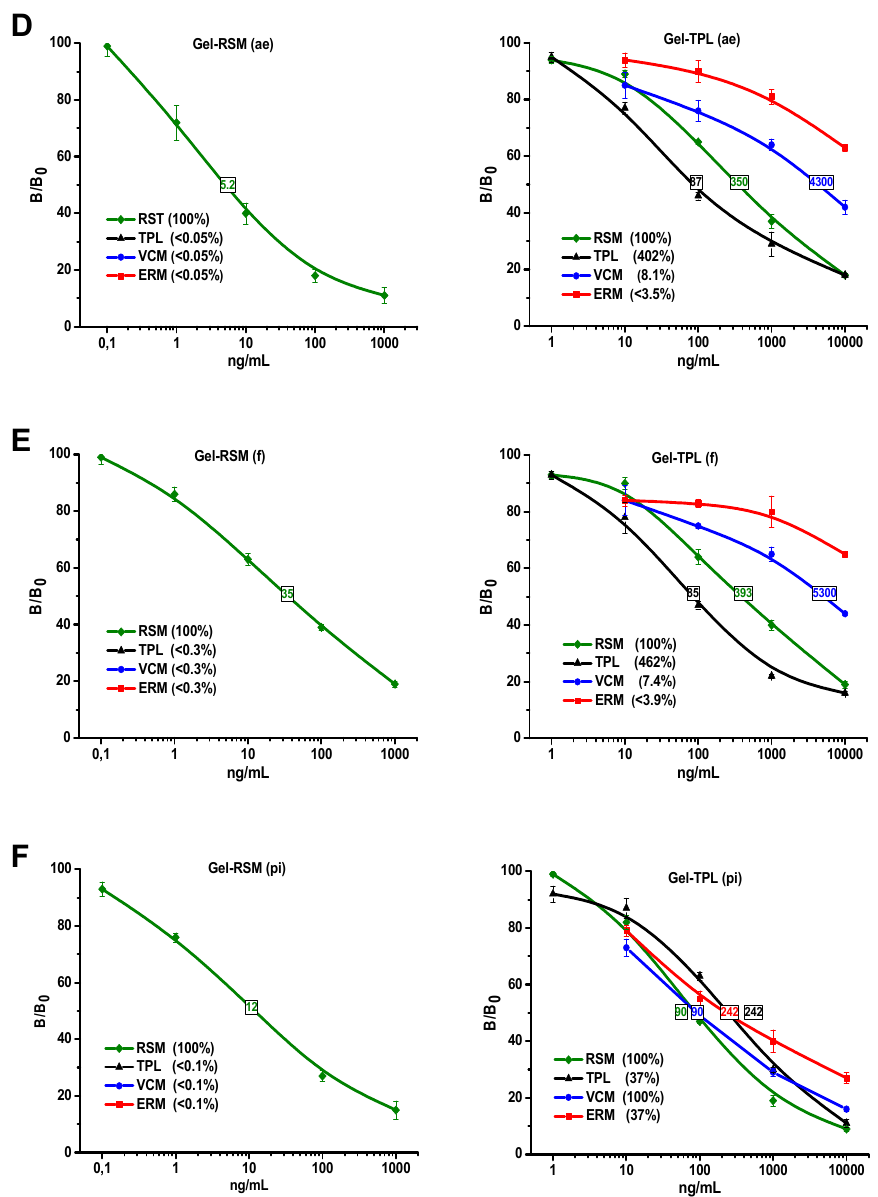
Figure 3. ( A–C ) The influence of coating antigen design (type of hapten and conjugation method) on the recognition spectrum of glycopeptides in immunoassay. The standard curves for indirect competitive enzyme-linked immunosorbent assay (ELISA) variants were derived from interaction between antibodies to BSA-RSM(pi-3) and immobilized conjugates based on ristomycin (RSM) ( left column ) and teicoplanin (TPL) ( right column ). Synthesis of conjugated protein–hapten antigens was carried out using the glutaraldehyde (ga) method ( A ), and reductive amination of the sodium periodate (pi)-oxidized carbohydrates ( B ), using carbodiimide condensation (edc) ( C ). ( D–F ) The influence of coating antigen design (type of hapten and conjugation method) on the recognition spectrum of glycopeptides in immunoassay. The standard curves for indirect competitive ELISA variants were derived from interaction between antibodies to BSA-RSM(pi-3) and immobilized conjugates based on RSM ( left column ) and TPL ( right column ). Synthesis of conjugated protein–hapten antigens was carried out using the active ester (ae) methods ( D ), in Mannich reaction with formaldehyde (f) ( E ) and periodate (pi) oxidation of haptens’ carbohydrate fragments ( F ). The values of IC 50 (ng/mL) and cross reactivity (%) are given in frames and brackets, respectively. Each symbol indicates the average value ( n = 3), and the error is represented by SD.